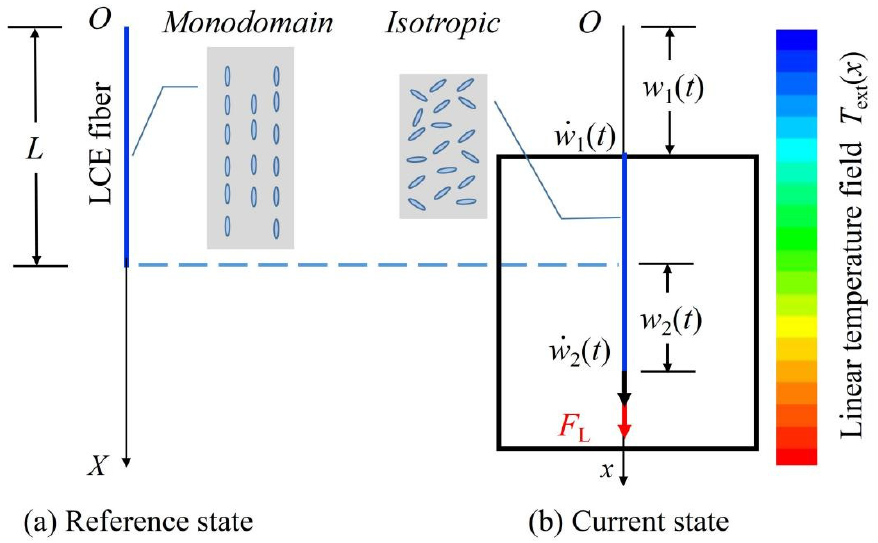
Figure 1. Schematic model for a LCE fiber connected with a translating frame in a linear temperature field. ( a ) Reference state; ( b ) Current state. The original length of the fiber is L . w 1 ( t ) , w 2 ( t ) are the displacements and velocities of the translating frame and the free end of the LCE fiber. When the displacements and velocities of the two ends of the LCE fiber are given, the tension force of the fiber can be determined.